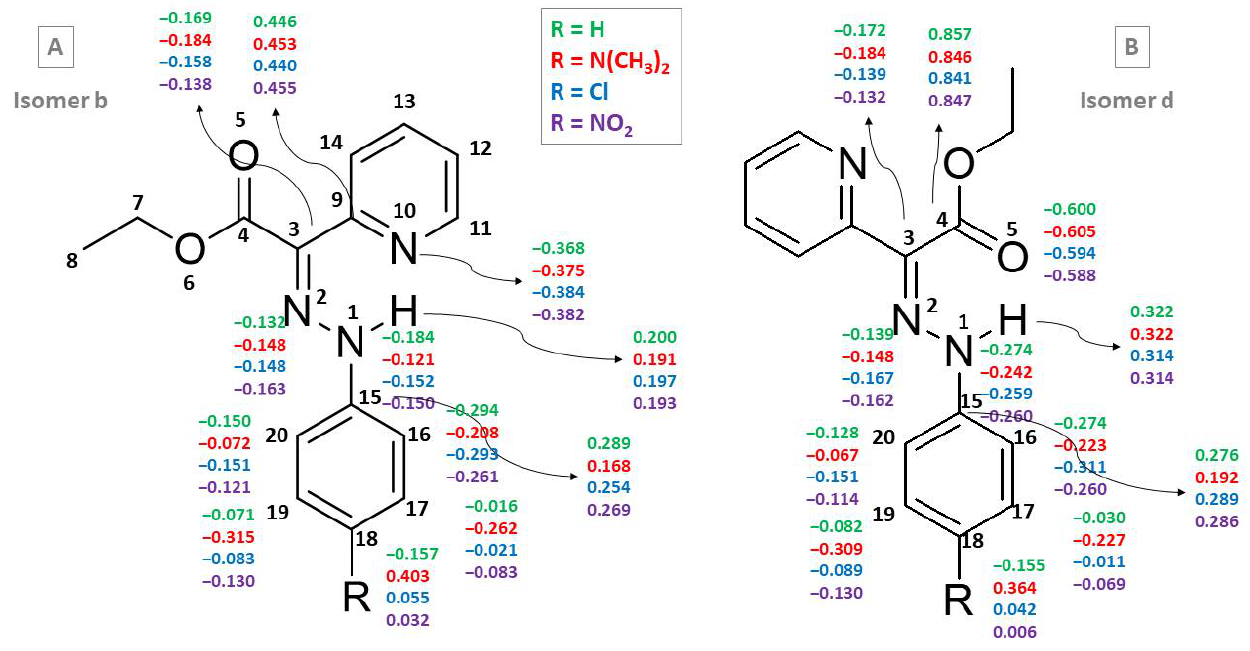
Figure 4. CHELPG charges for selected atoms of isomers b ( A ) and d ( B ) of compounds 1 , 2 , 7 and 11 at ε = 1. We performed sensitivity analysis of partial charges and bond length changes due to variation of different factors: calculation method, isomers, tautomers and